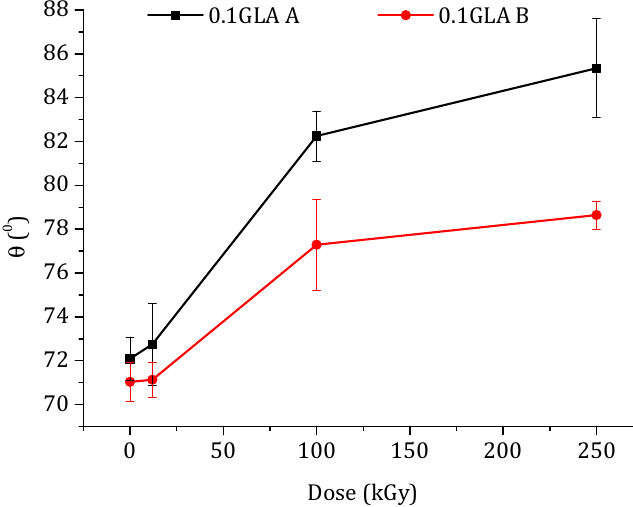
Figure 9. Water contact angle of the prepared membranes with GLA-crosslinked chitosan as a function of the irradiation dose: (A) top membrane surface dried in air (black line) and (B) bottom membrane surface in contact with the glass plate.